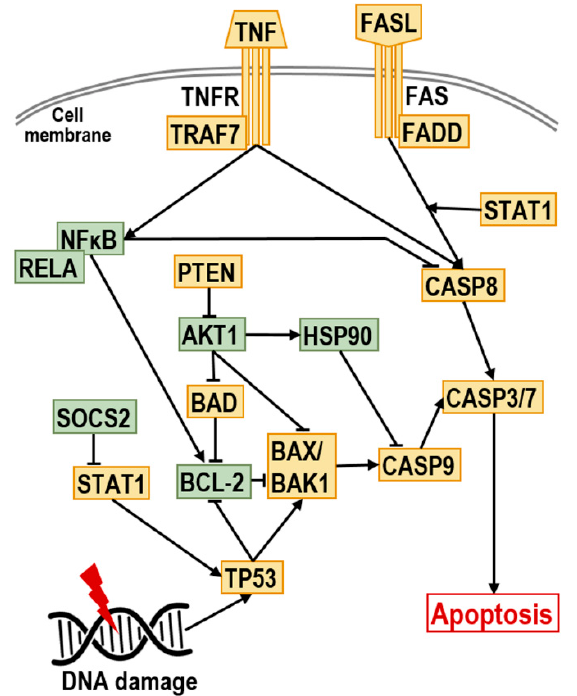
Figure 5. Pathway of the investigated genes involved in apoptosis. TP53: tumor protein p53 data;